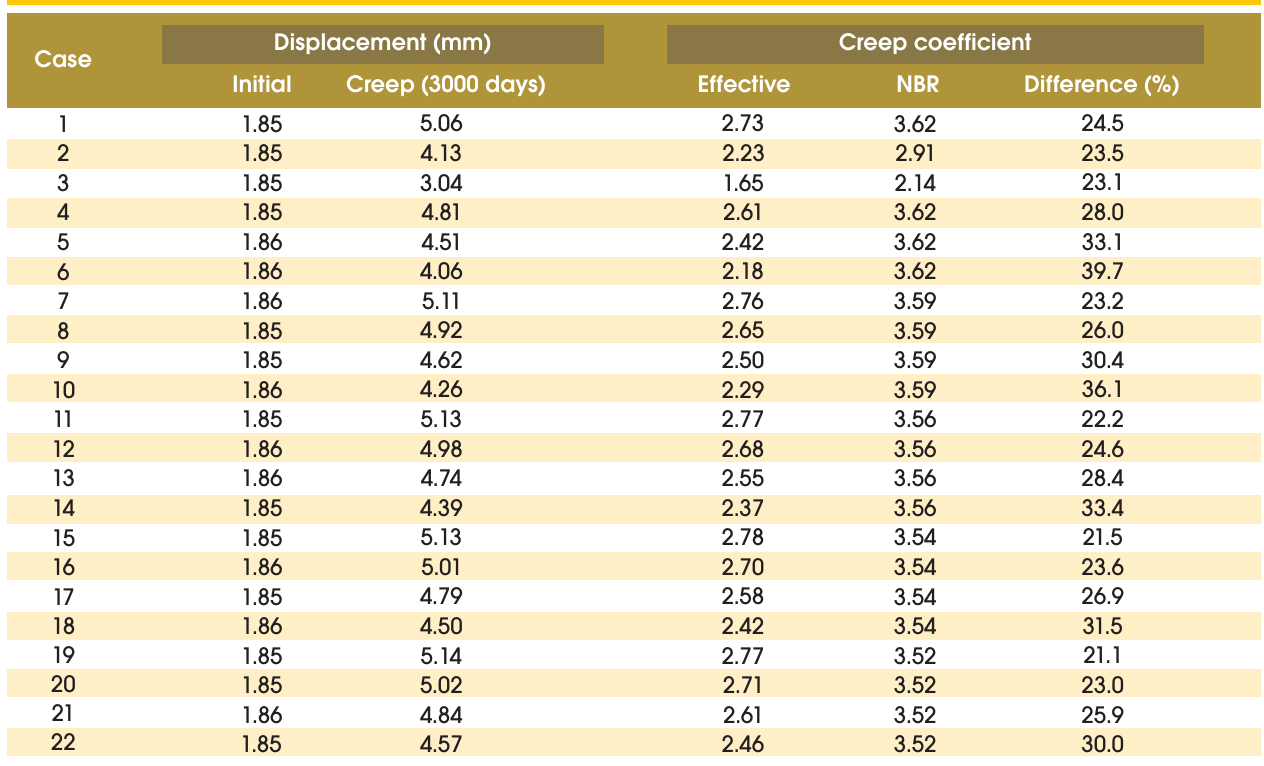
Table 4 – Longitudinal displacement on the column